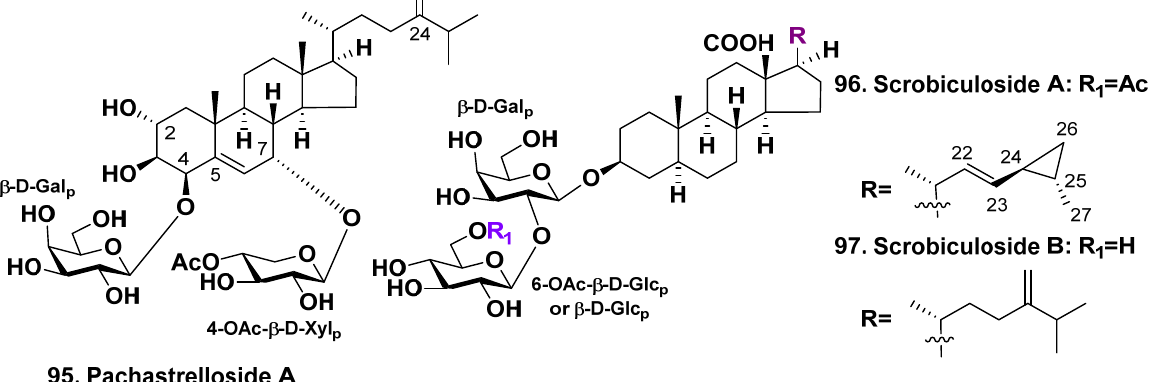
Figure 12. Structure of pachastrelloside A ( 95 ) from Pachastrella sp., and scrobiculosides A ( 96 ), and B ( 97 ) from Pachastrella scrobiculosa .